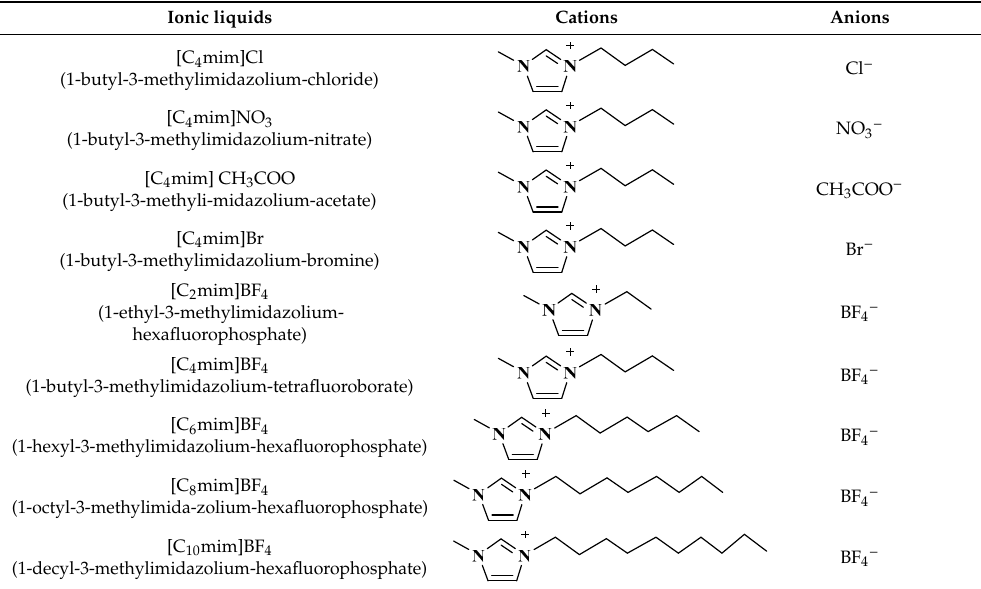
Table 5. Chemical structures of ionic liquids.